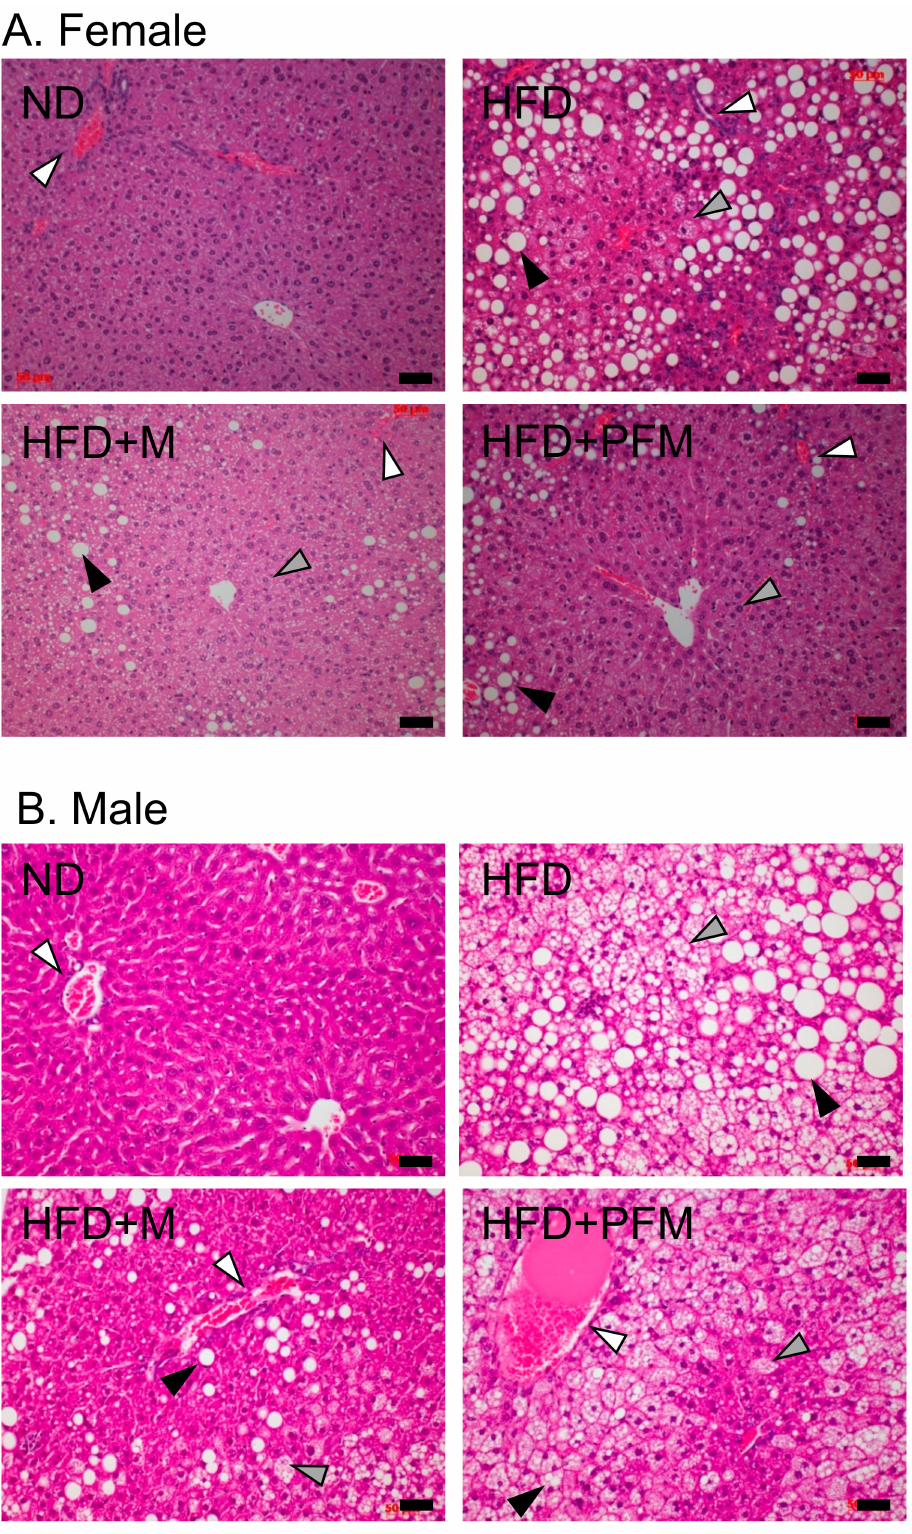
Figure 3. Hematoxylin and eosin (H&E) staining of liver tissue sections. Liver tissue sections from the female ( A ) and male ( B ) groups are shown. The normal diet group (ND), high-fat diet group (HFD), HFD containing miso group (HFD+M) and HFD containing pre-fermented miso group (HFD+PFM) are shown. White, gray, and black arrowheads indicate portal vein, micro-vesicles, and macro-vesicles, respectively. Bars = 50 µ